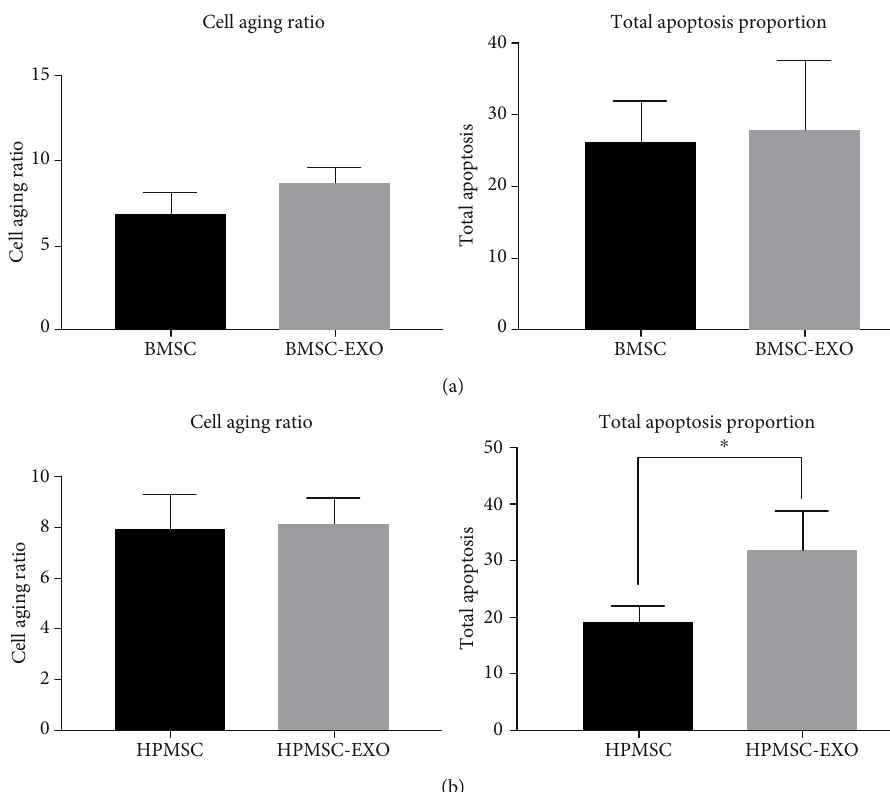
Figure 10: (a) Comparison of the e ff ects of BMSCs and their secreted exosomes. (b) Comparison of the e ff ects of HPMSCs and their secreted